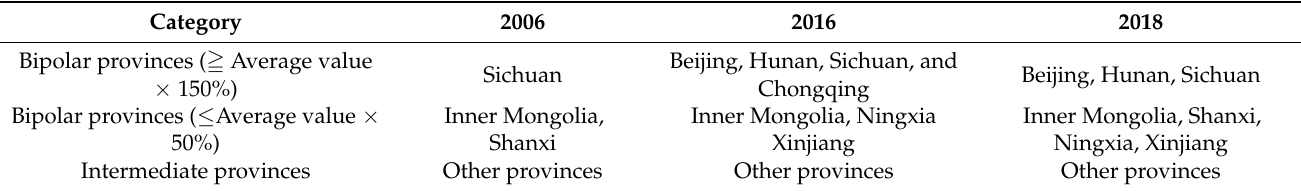
Table 8. Spatial polarization of EWP in China in 2006, 2016 and